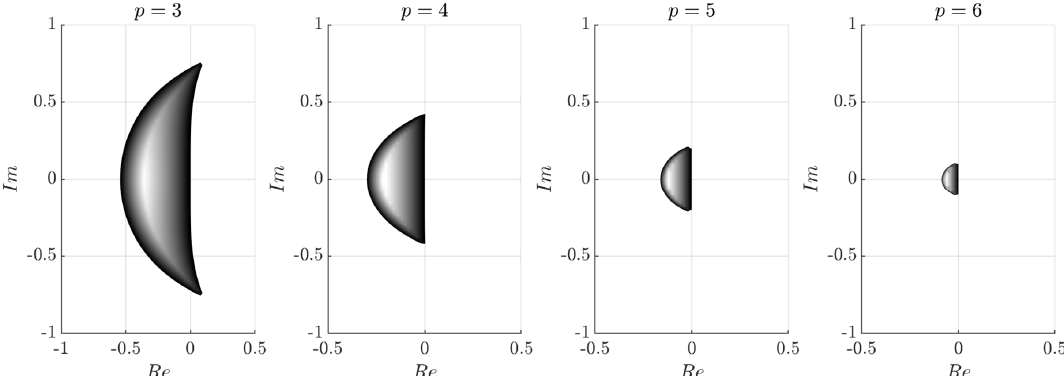
Fig. 12. Stability regions of Adams-Bashforth methods of order p.